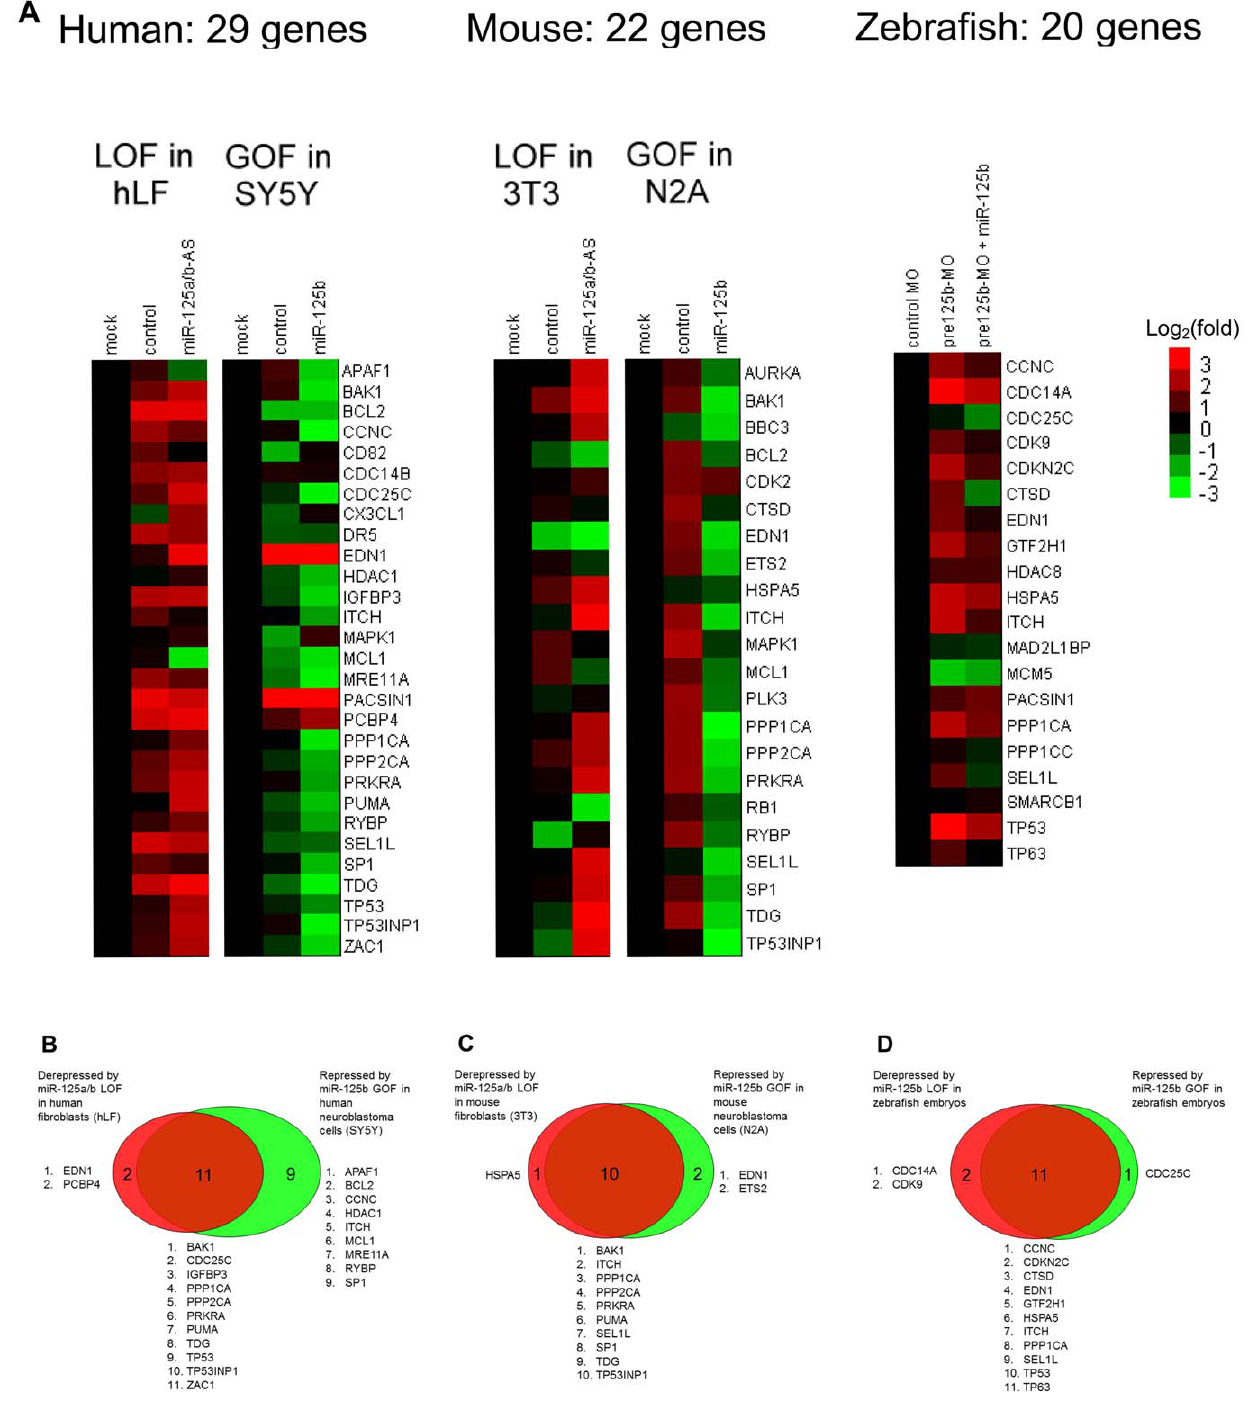
Figure 2. GOF/LOF screen for p53 network genes regulated by miR-125b. (A) Loss-of-function (LOF) screens were performed in human primary lung fibroblasts (hLF) or mouse 3T3 fibroblasts by transfecting an antisense RNA against both miR-125a and miR-125b (miR-125a/b-AS), or by microinjecting morpholinos (MO) against pre- mir-125b hairpin precursors (all 3 isoforms) into zebrafish embryos. Gain-of-function (GOF) screens were performed in human SH-SY5Y and mouse N2A neuroblastoma by transfecting the miR-125b duplex into cells in culture, or by coinjecting the miR-125b duplex with the morpholinos againstpre- mir-125b intozebrafishembryos.Foldchanges in geneexpressionweremeasuredbyqRT-PCRtwenty-fourhoursaftertransfectionor injection, relative to the mock and negative control miRNA or morpholino, and shown as log 2 (fold change) using a heat-map. (B) Human: 13 genes were significantly derepressed by a loss of miR-125b, while 20 genes were significantly repressed by a gain of miR-125b, making a total of 22 genes that passed the screen (P , 0.05, fold change . 1.3, relative to mock control). (C) Mouse: 11 genes were significantly derepressed by a loss of miR-125b, while 12 genes were significantly repressed by a loss of miR-125b, making a total of 13 genes that passed the screen (P , 0.05, fold change . 1.3, relative to mock control). (D) Zebrafish: 13 genes were significantly derepressed by a loss of pre- mir-125b (P , 0.05, fold change . 1.3, relative to control MO), while 12 genes were significantly repressed/rescued by a gain of miR-125b (P , 0.05, fold change . 1.3, relative to pre- mir-125b MO), making a total of 14 genes that passed the screen. All experiments were performed with at least three biological replicates.